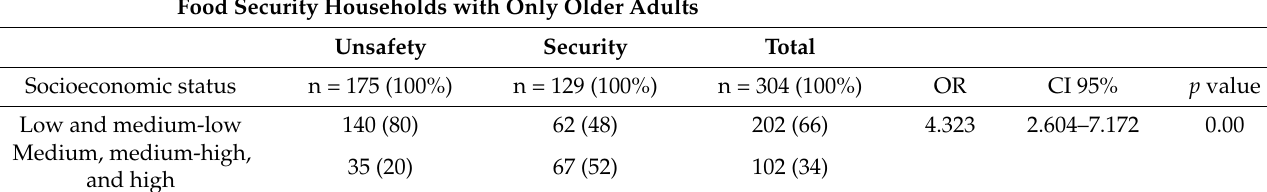
Table 5. Relationship between socioeconomic status and food security in older